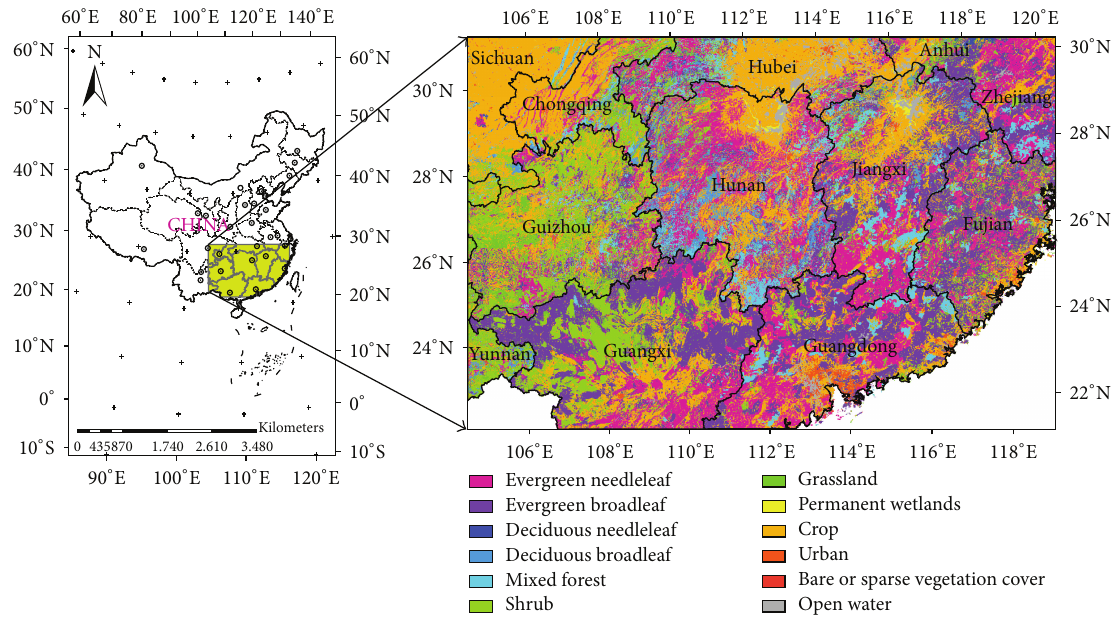
Figure 1: The location and land cover map in the year 2005 in Southern